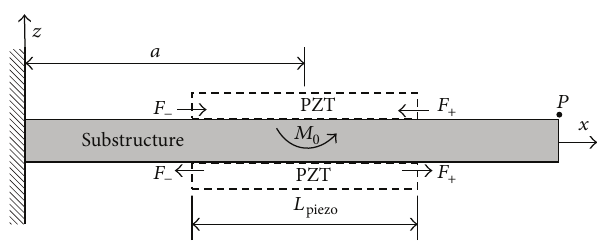
Figure 4: PZT’s action on the